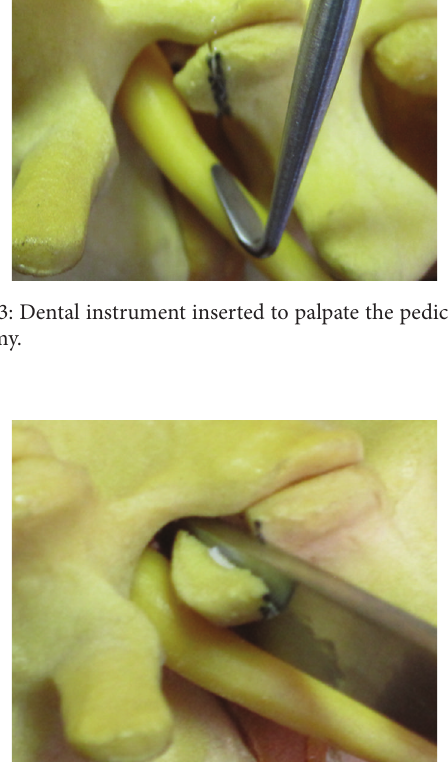
Figure 4: Osteotome performing the lumbar partial